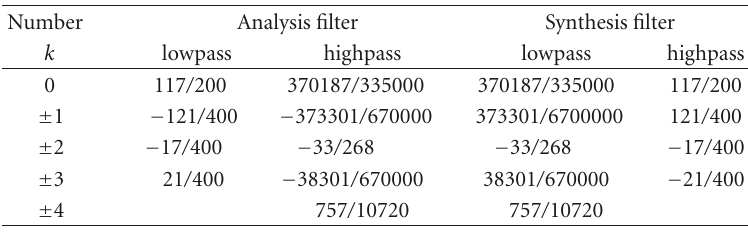
(a) All the coe ffi cients of new 9/7 filter